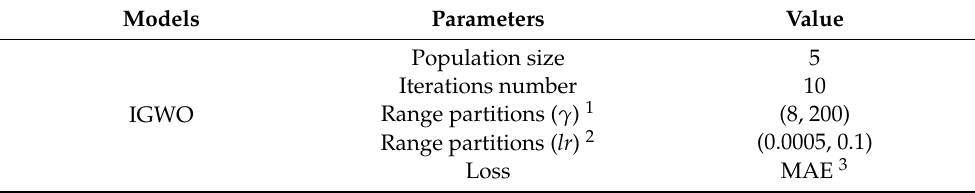
Table 1. Initial parameters of improved grey wolf optimizer